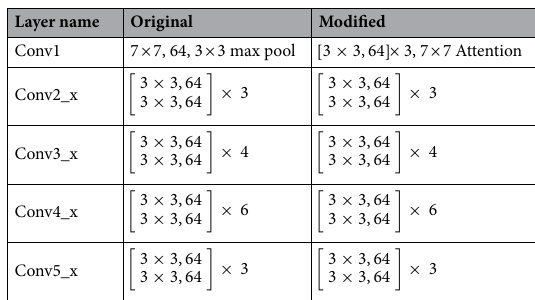
Table 3. Architecture details of ResNet-34 original and